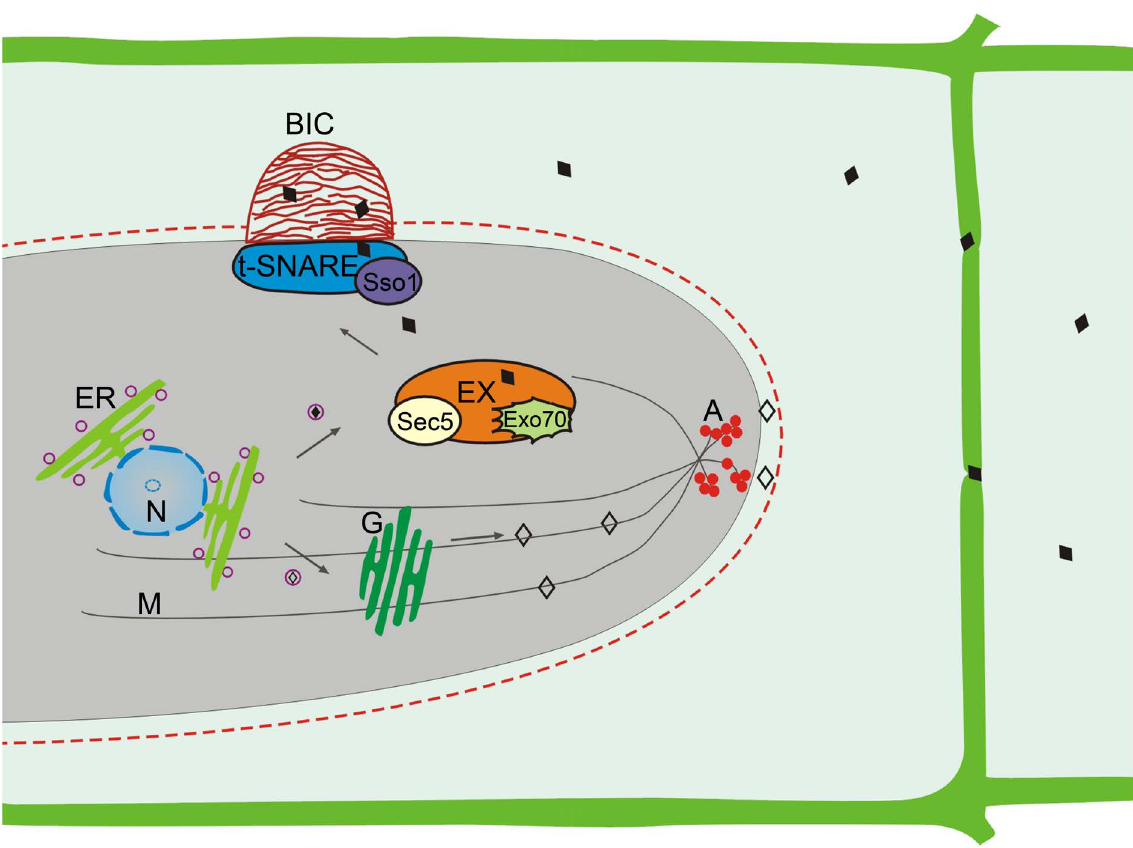
Figure 2. Two effector secretion mechanisms identified in M.oryzae . The apoplastic effectors ( e ) utilize the conventional ER-Golgi secretion pathway for secretion. Disruption of the cytoskeleton by benzimidazoleand LatA treatments interferes with the secretion of apoplastic effectors. In contract, the secretion of cytoplasmic effectors ( ¤ ) into the BIC is independent of the Golgi bodies and cytoskeleton but involves the exocyst complex and t-SNAREs. A, cortical actin; ER, endoplasmic reticulum; EX, exocyst complex; G, Golgi bodies; M, microtubules; N, Nucleus.